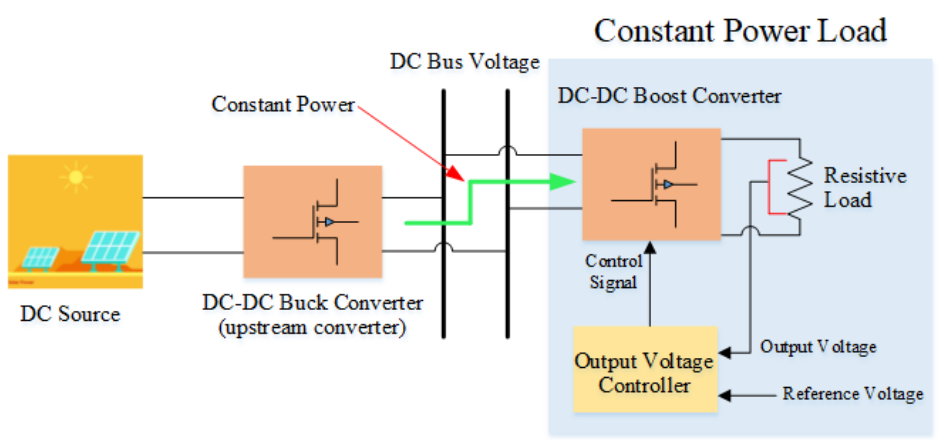
Figure 1. Structure of DC microgrid.